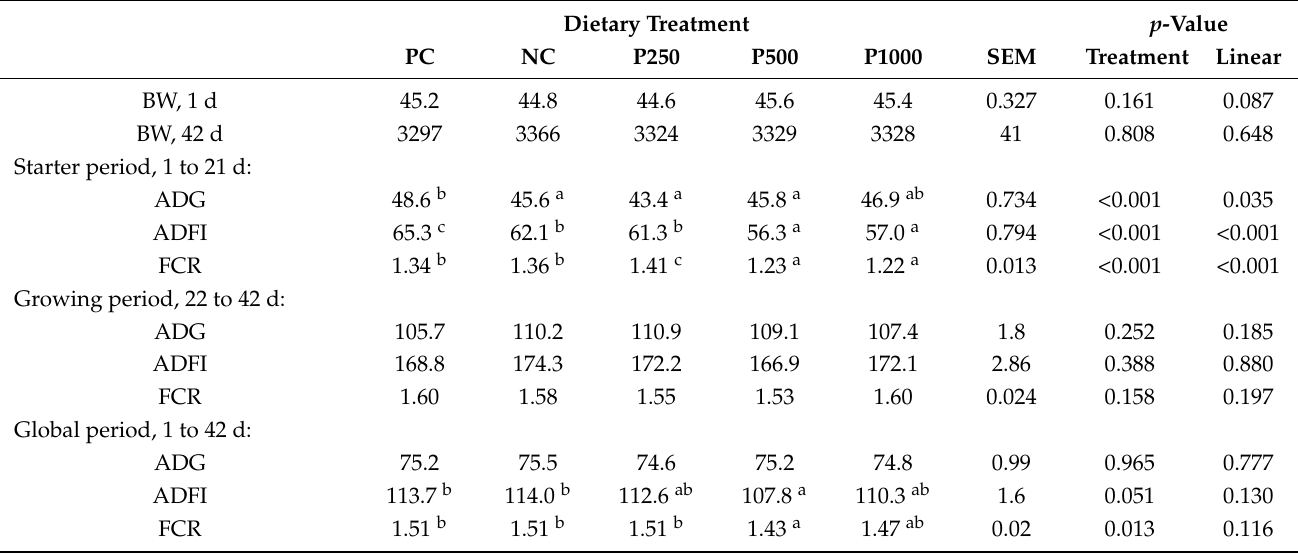
Table 3. Long-term trial: Initial and final body weight (BW, g), daily weight gain (ADG; g/d), daily feed intake (ADFI, g/d), and feed conversion ratio (FCR, g feed/g weight) of broilers fed feeds including different levels of phytase from 1 to 42 days of